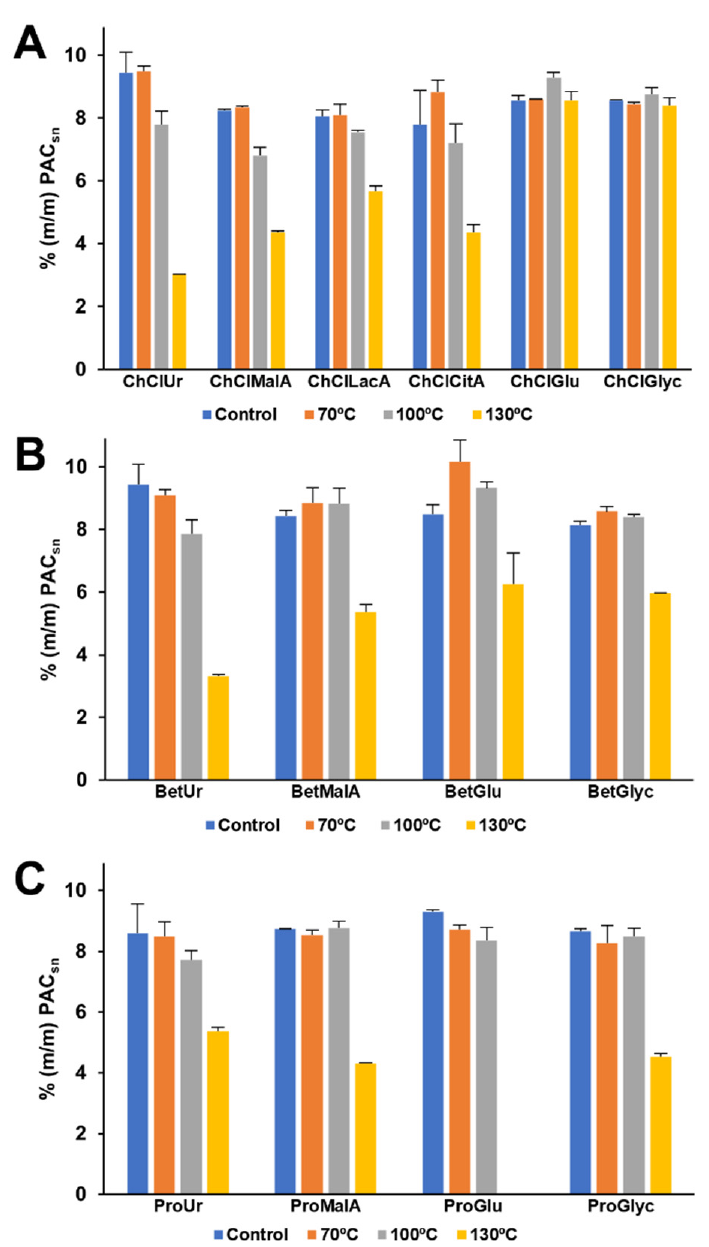
Figure 1. Quantification of PACs solubilized in different ESs and incubated in MAE at different temperatures. ( A ) ChCl-based; ( B ) Bet-based; ( C ) Pro-based.